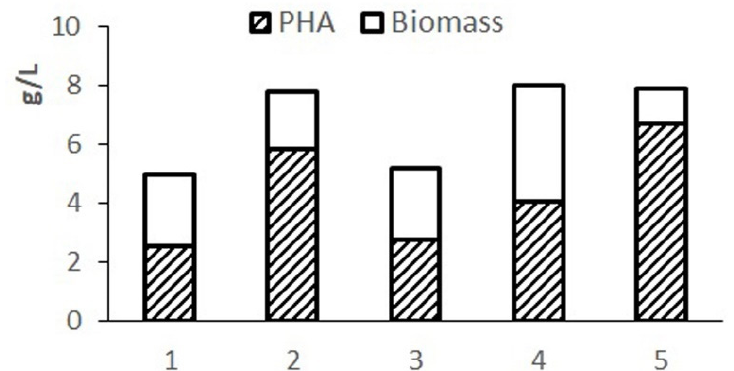
Figure 1. Indicators of the culture of Cupriavidus necator B-10646 when grown on molasses hydrolysate and Schlegel’s medium: 1-, 2-, 3-, 10-, 20-, 30-fold dilution of molasses hydrolysate, respectively; 4-complete Schlegel medium; 5-with 50% nitrogen content. Biomass concentration (X, g/L), polymer (% of CDW).